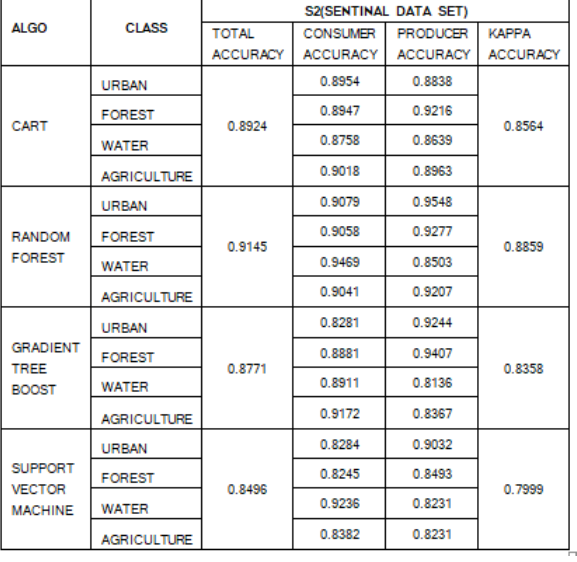
Figure 12: Accuracy generated by classification algorithms over sentinel-2 datasets fication output generated by CART classification algorithm